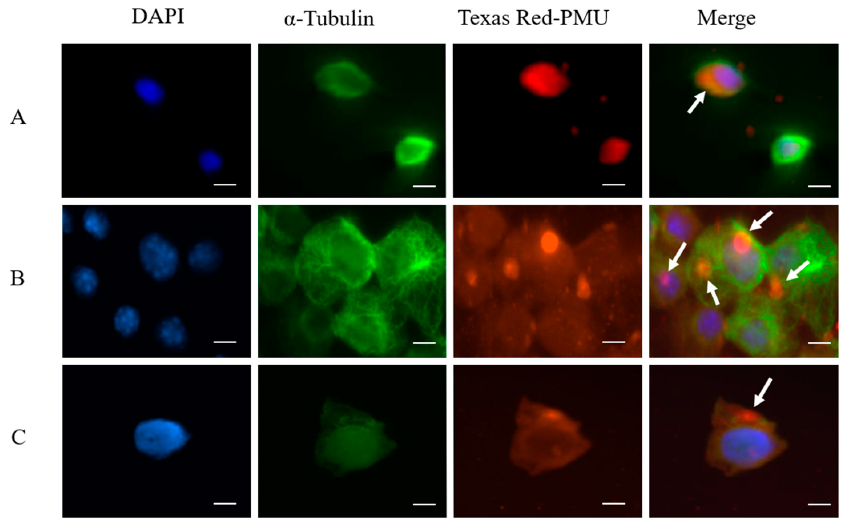
Figure 6. Fluorescence microscopy analysis of PMU-treated cells and nuclear localization sequences. Texas Red-labeled PMU (63 nM) was incubated for 1 h at room temperature with the cell lines ( A ) human neuroblastoma, SH-SY5Y, ( B ) murine microglia, BV-2, and ( C ) human embryonic kidney, HEK293. The cells were then treated with anti- α -Tubulin antibodies (1:1000, in green) to stain the cytoskeleton and with DAPI to label the nucleus (in blue). Cells were visualized under a fluorescence microscope. Scale-bars: 10 µm. The arrows in the merge view indicate the presence of PMU interacting with the cells in the cytoplasm, perinuclear region and in the nuclei. The pictures are representative of at least three independent assays.